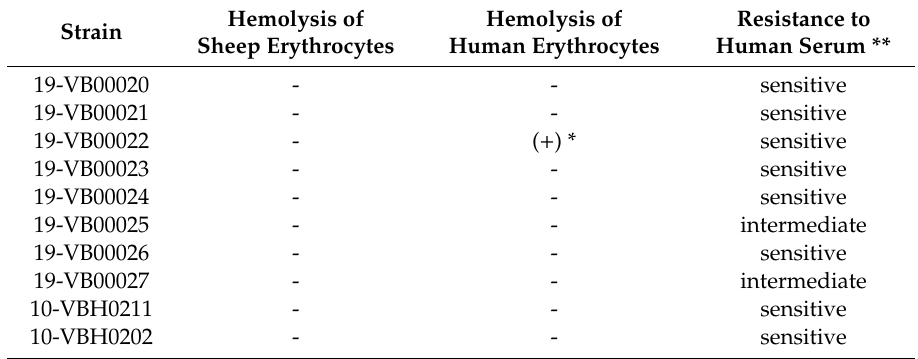
Table 4. Virulence-associated phenotypes, hemolytic activity against sheep and human erythrocytes, and resistance against human serum. Hemolysis of Hemolysis of Strain Sheep Erythrocytes Human Erythrocytes